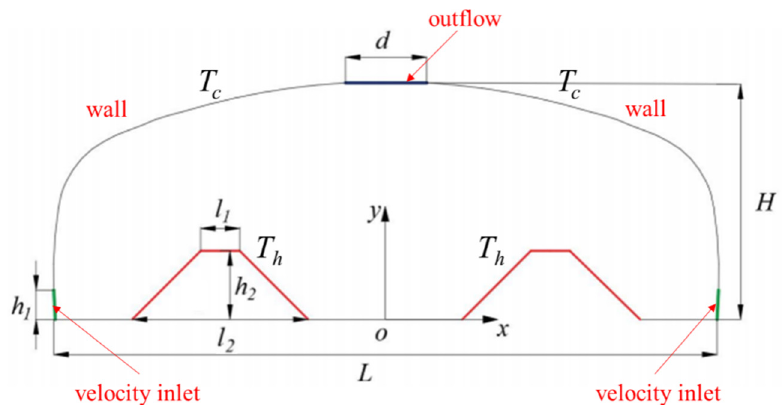
Figure 1. Schematic of the arc-shaped cavity.